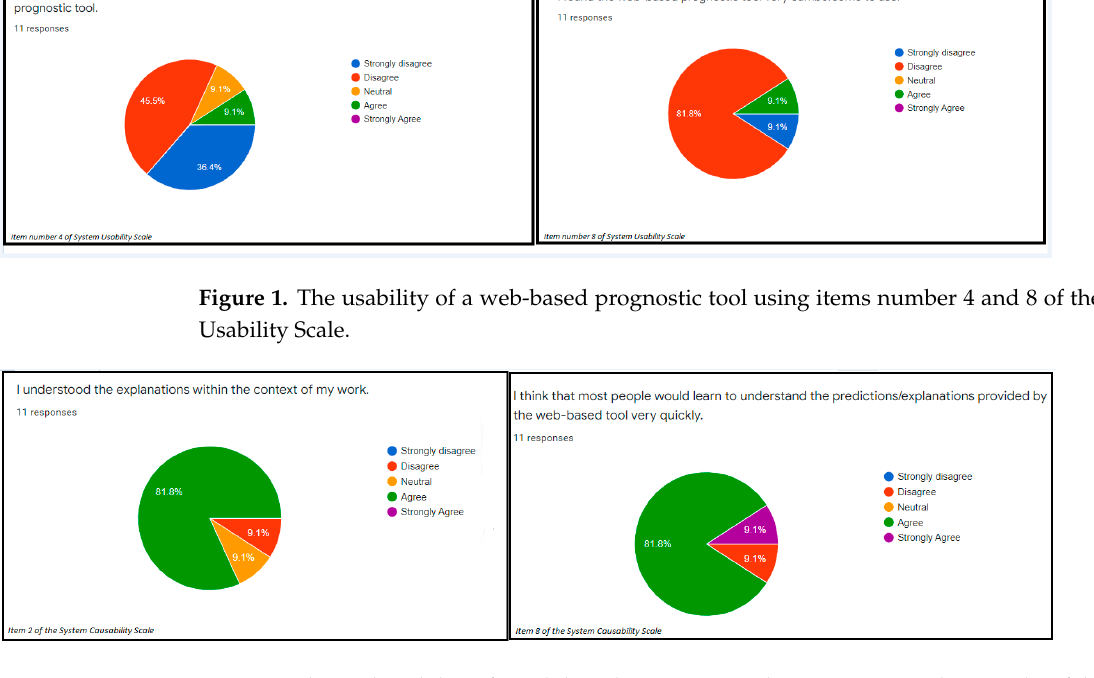
Figure 3. The potential of a web-based tool in cancer management. 3.3. Fidelity and Interpretability For fidelity components, 9.1% strongly agreed while 54.5% agreed about the sound- ness of the model (Figure 4: item 7 of the SCS). Similarly, 18.2% strongly agreed while 45.4% agreed about the completeness of the web-based prognostic tool (Figure 4: item 3 of the SCS). For the interpretability components, 27.3% strongly agreed about parsimony of the web-based prognostic tool while 54.5% agreed about the parsimony of the tool (Fig- ure 4: item 4 of the SCS). Additionally, 9.1% strongly agreed while 54.5% agreed on the clarity of the examined web-based prognostic tool (Figure 4: item 10 of the SCS). Figure 4. Measuring the essential components of explainability using the System Usability Scale. The fidelity includes soundness and completeness (items 7 and 3 of SUS), while interpretability in- cludes parsimony and clarity (items 4 and 10 of SUS).